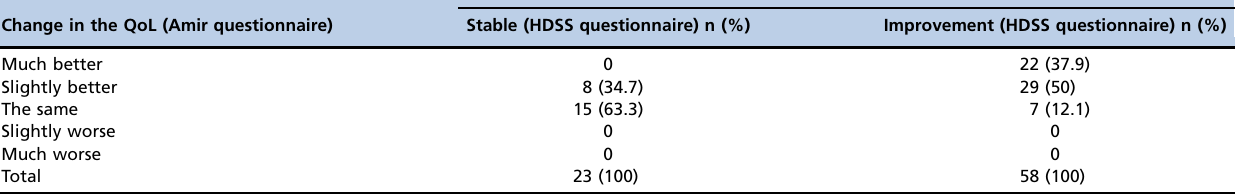
Result of treatment on